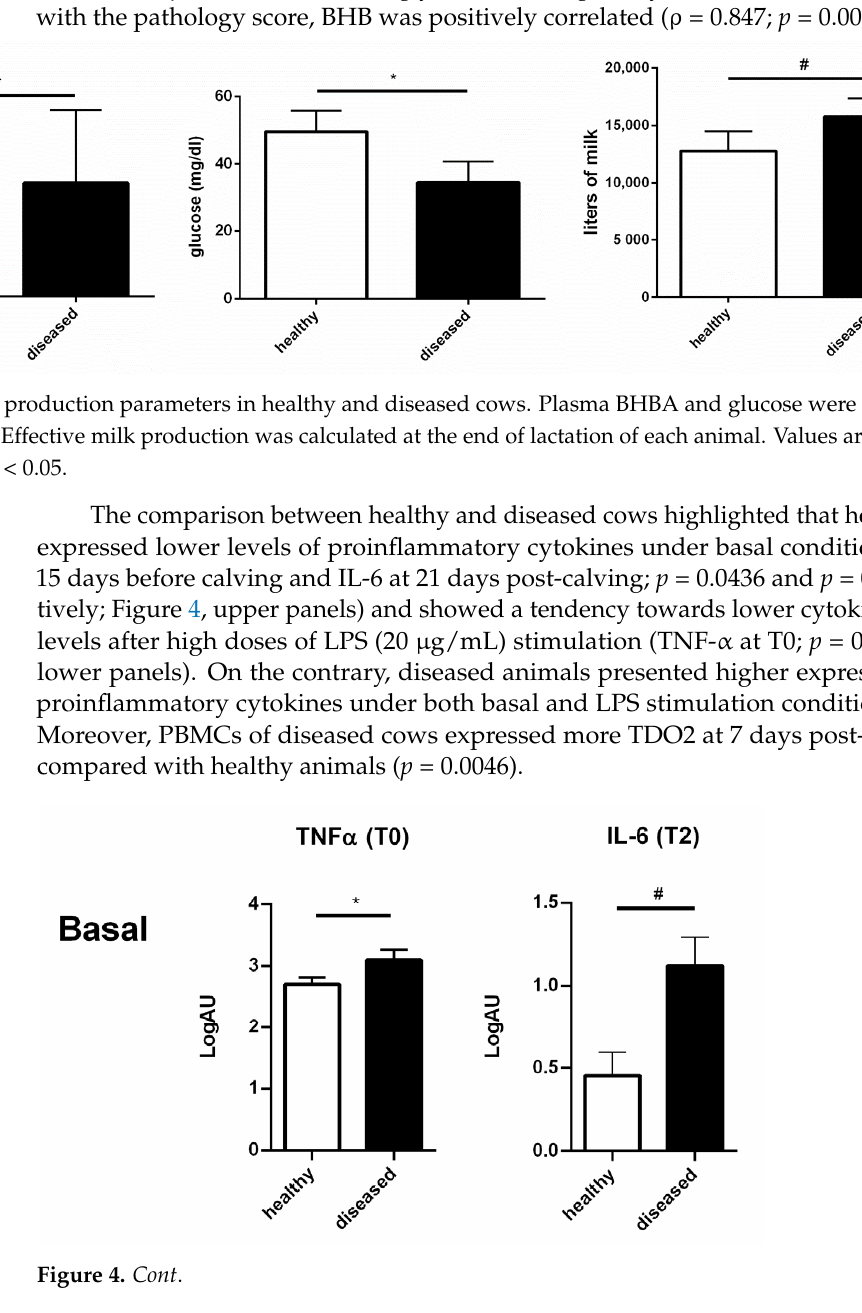
Figure 4. Different responses of PBMCs of healthy and diseased cows. PBMCs of diseased (black bars) and healthy (white bars) cows expressed different levels of proinflammatory cytokines and kynurenin pathway genes under basal conditions and after LPS stimulation at different time points (T0 = 15 days before calving; T1 = 7 days post-calving, T2 = 21 days post-calving). Only the graphs of cytokine expression with p < 0.1 or p < 0.05 are reported. Values are medians, Q1 and Q3. Gene expression was analyzed by RT qPCR. # p < 0.1, * p < 0.05, ** p < 0.01. 3.4. High and Low Responders Differently Expressed Cytokine Genes Unstimulated PBMCs of low responders showed a tendency towards higher levels of expression of the proinflammatory cytokines IL-1 β ( p = 0.057) and TNF- α ( p = 0.057) compared to high responders at T1 (Figure 5, upper panels). PBMCs of high responders seemed to better control LPS stimulation at a high dose (20 μ g) at 15 days before calving and 21 days post-calving in terms of lower cytokine expression levels (IL-1 β at T0; p = 0.0643; IL-1 β , IL-6 and TNF- α at 21 days post-calving; all p = 0.1; Figure 5, lower panels). No differences in the kynurenine pathway gene expression were observed in either un- stimulated or stimulated PBMCs at any time point.